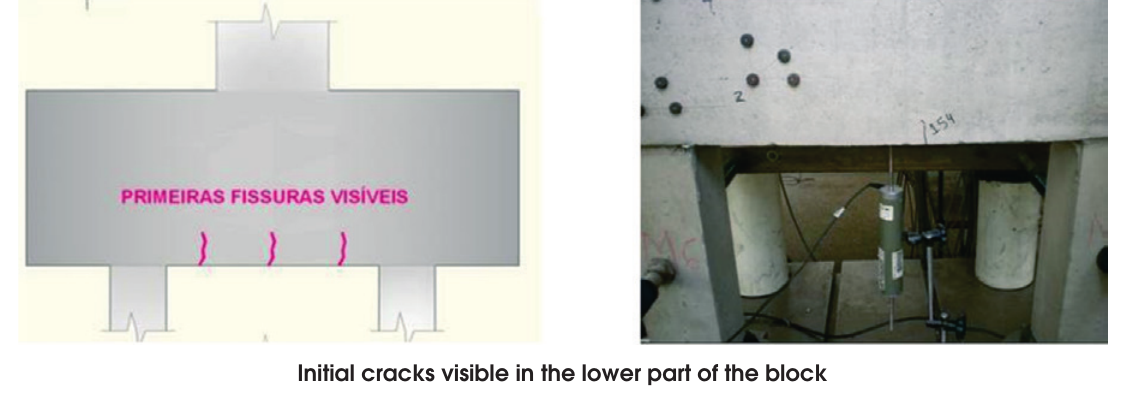
Initial cracks visible in the lower part of the block